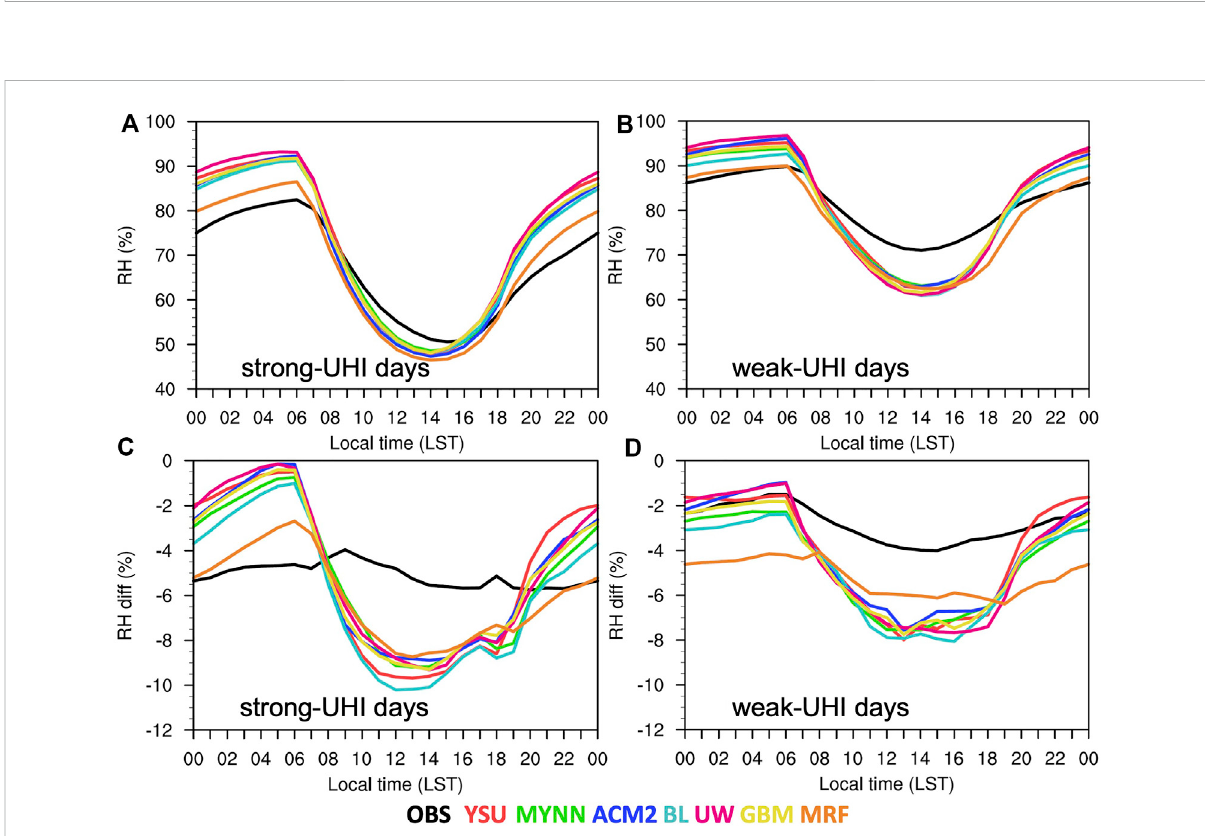
FIGURE 12 (A) Comparisons of the PBL schemes on the composite domain-averaged near-surface relative humidity over the urban region on strong-UHI daysand (C) thecorrespondingrelativehumiditydifferencebetweenurbanandruralareas(urbanminusrural). (B,D) aresimilarto (A,C) butonweak- UHI